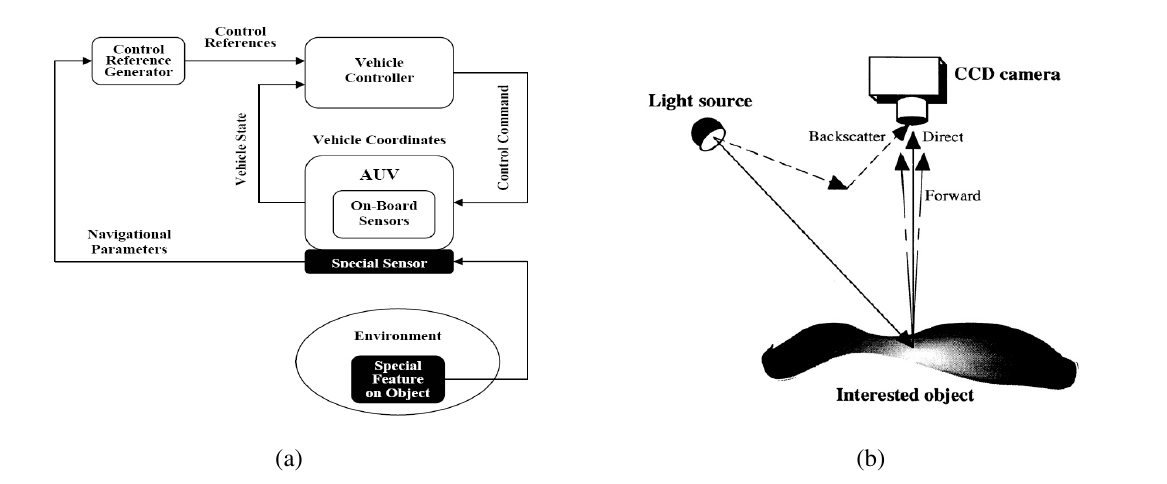
(b) shows the components of an underwater image